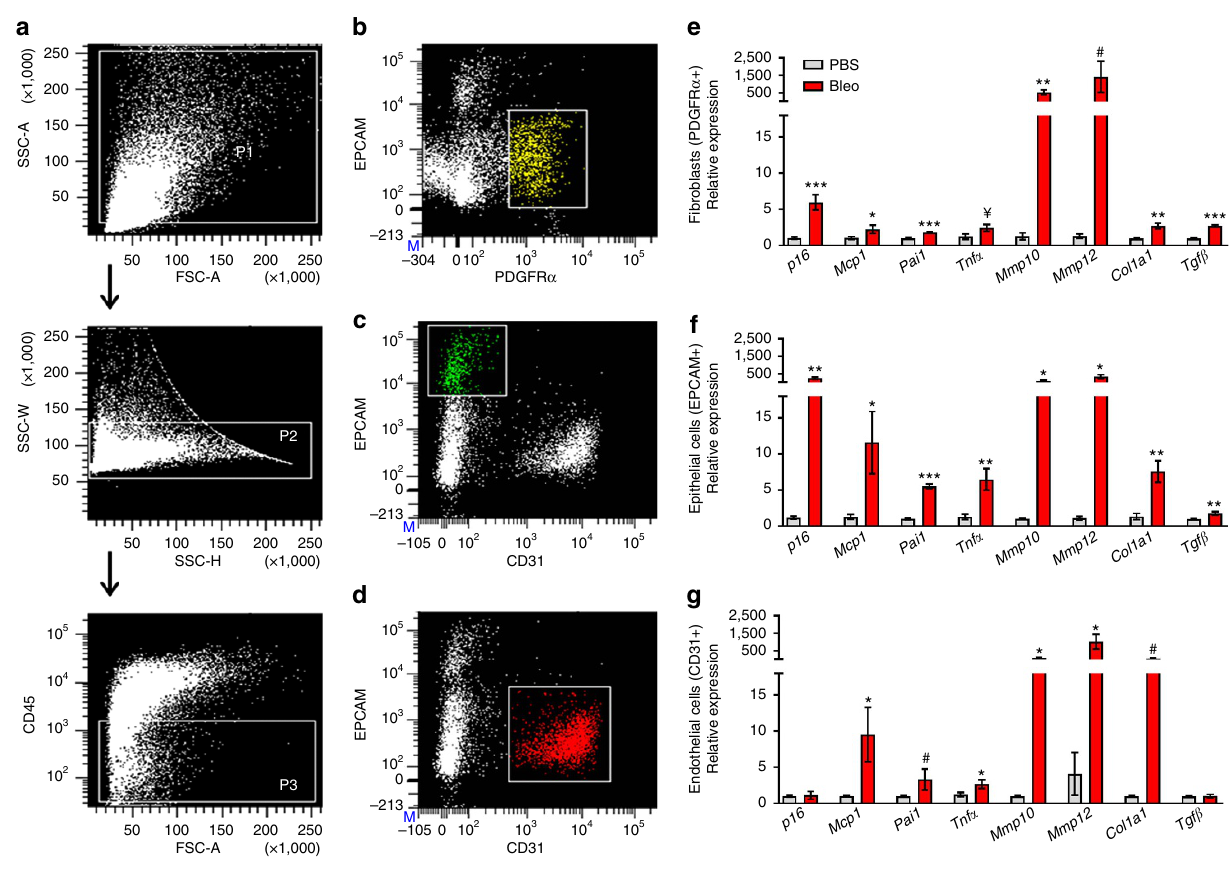
Figure 2 | Bleomycin-induced senescence in murine lung cells. ( a – d ) Gating strategy for isolation of fibroblasts, epithelial and endothelial cells from the lungs of mice 14 days post-aerosolized instillation of bleomycin (Bleo) or PBS. ( a ) Total single-cell suspensions (P1) were gated to exclude doublets (P2) and CD45 þ cells (P3). ( b ) Fibroblasts (PDGFR a þ , EPCAM (cid:2) , CD31 (cid:2) and CD45 (cid:2) ), ( c ) epithelial cells (EPCAM þ , PDGFR a (cid:2) , CD31 (cid:2) and CD45 (cid:2) ) and ( d ) endothelial cells (CD31 þ , PDGFR a (cid:2) , EPCAM (cid:2) , CD45 (cid:2) ) were sorted from the P3 population. The expression of p16 , SASP genes ( Mcp1 , Pai1, Tnf a , Mmp10, Mmp12 ) and fibrotic genes ( Col1a1 and Tgf b ) were quantified by RT–PCR and are expressed relative to Hprt levels in sorted populations of ( e ) fibroblasts, ( f ) epithelial cells and ( g ) endothelial cells (mean ± s.e.m.; PBS n ¼ 8 (grey), Bleo n ¼ 6 (red); t -test, *** P o 0.0005, ** P o 0.005, * P o 0.05, f P r 0.07 and # P r